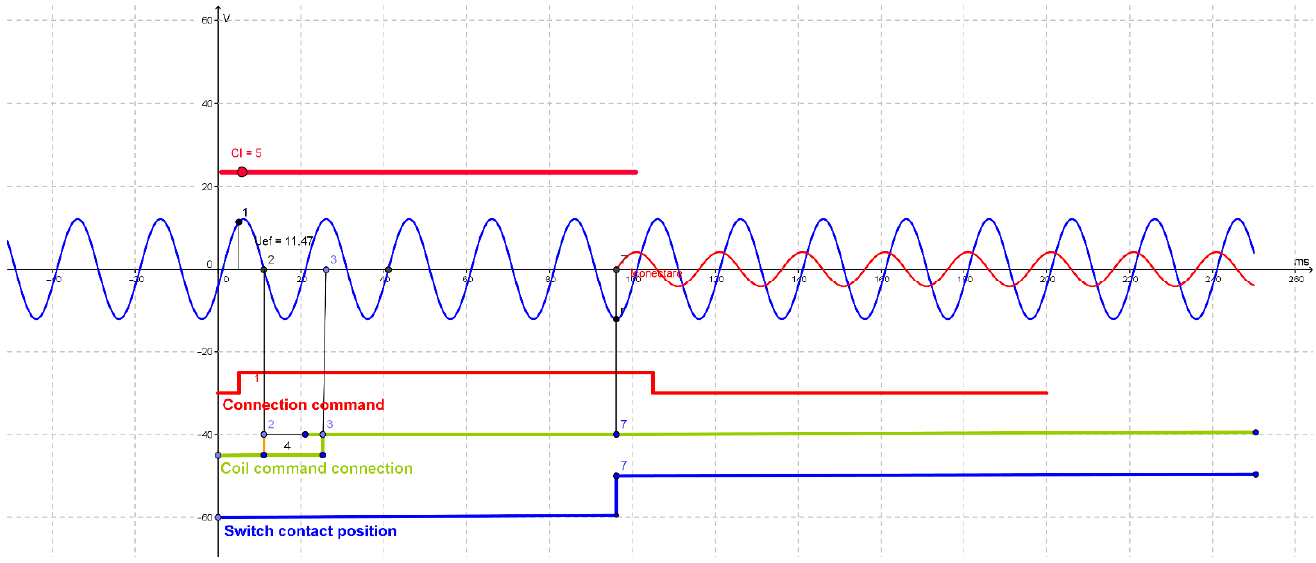
Figure 23. The simulation of monophasic power supply system on the connecting process of the circuit breaker on t 1 = t command = 5 ms. Table 10. The main parameters used in simulation of connection process of the circuit-breaker.